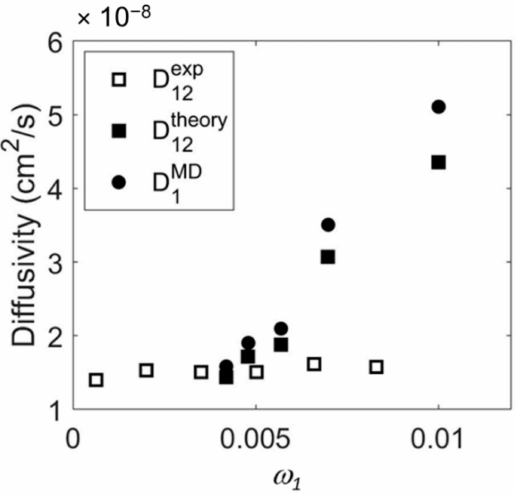
Figure 8. Values of water intra-diffusion coefficient determined from MD simulations, D MD water–PEI mutual diffusion coefficient determined from Equation (22), D theory mutual diffusion coefficient determined experimentally from FTIR spectroscopy, D exp